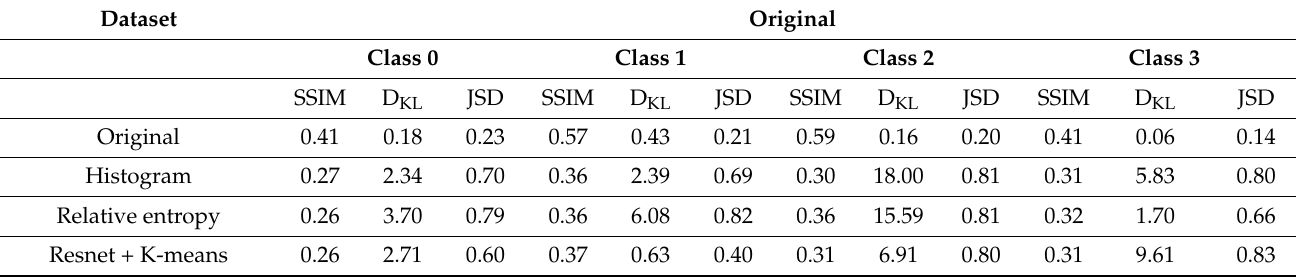
Table 4. Similarity